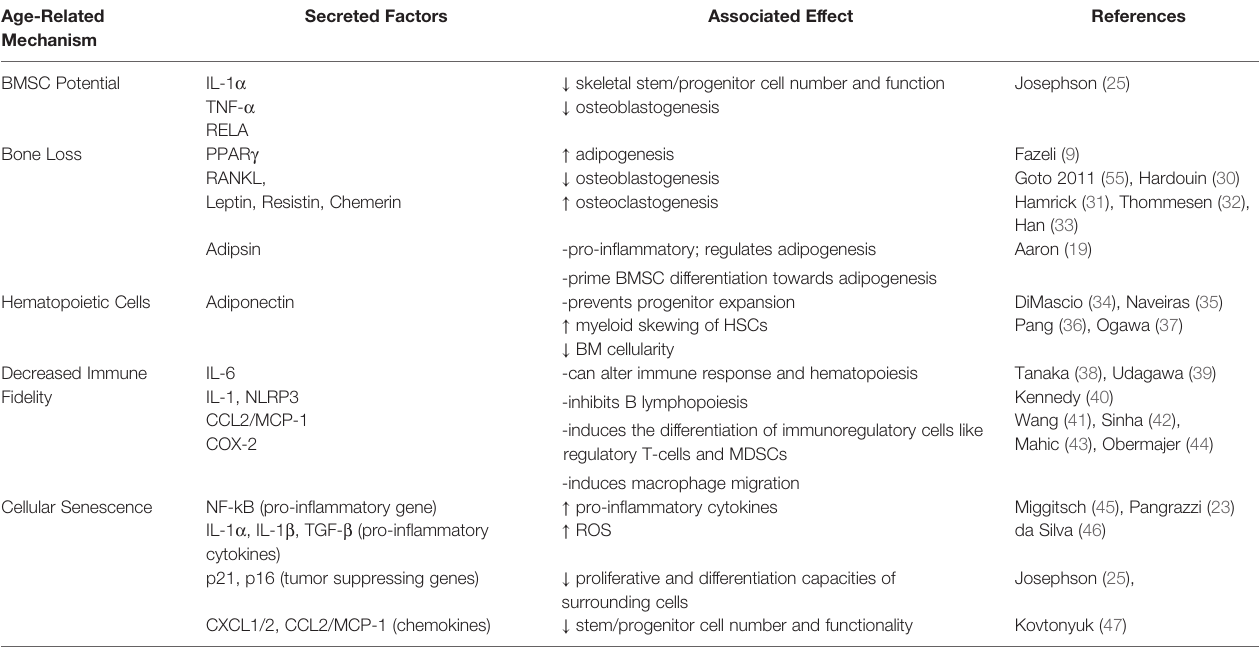
TABLE 1 | BMAT-derived factors and the age-associated